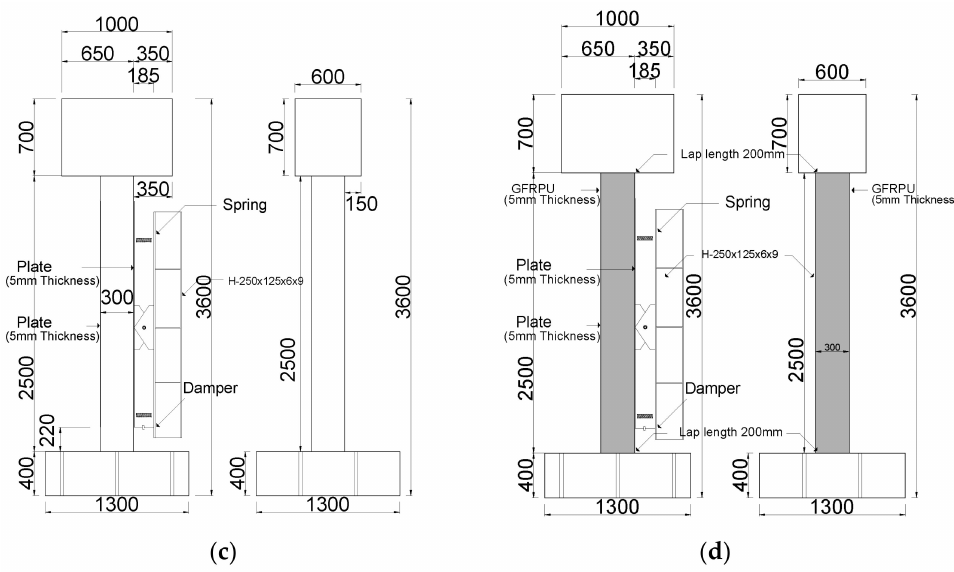
Figure 2. Four specimens: ( a ) unreinforced specimen, ( b ) GFRPU-reinforced specimen, ( c ) LTMD control specimen, and ( d ) hybrid control specimen (unit: mm).